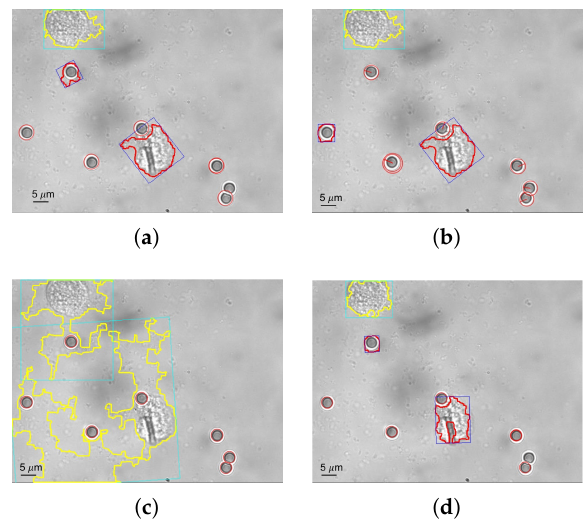
Figure 22. Processed images of human endothelial cells and silica beads in Matrigel using various perception methods: ( a ) MSER with circularity parameter; ( b ) SURF; ( c ) Canny edge detector with Otsu’s thresholding; ( d ) MSER.